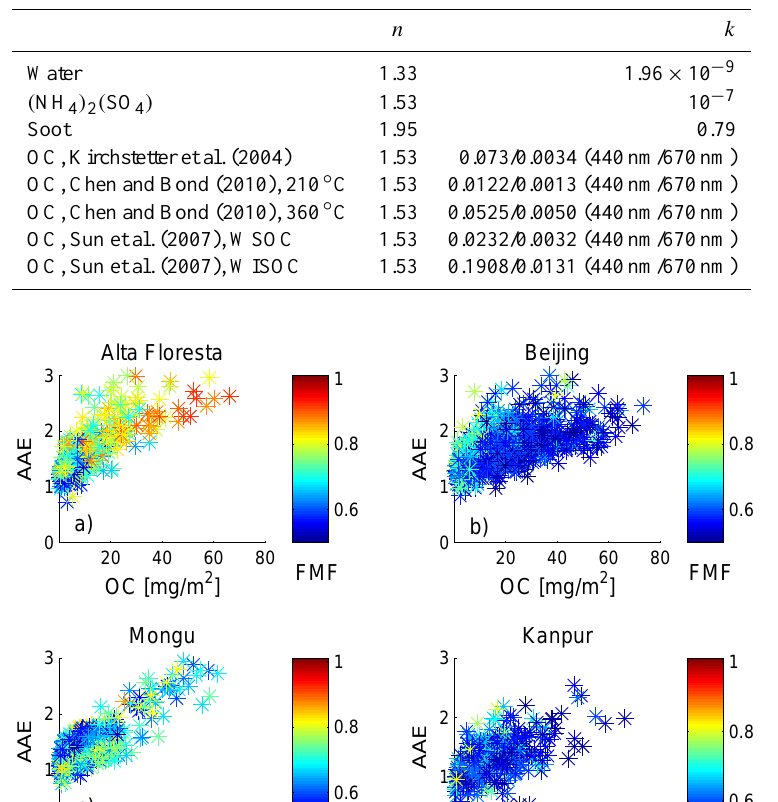
to be larger than the mean of the imaginary indices at 670, 870 and 1020